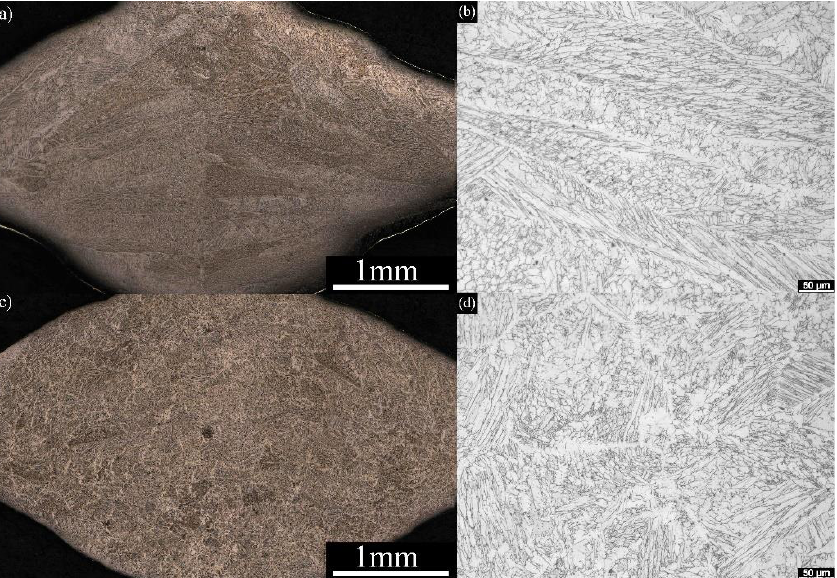
Figure 4. Microstructure of the WM: ( a , b ) without ultrasonic treatment and ( c , d ) with ultrasonic treatment.